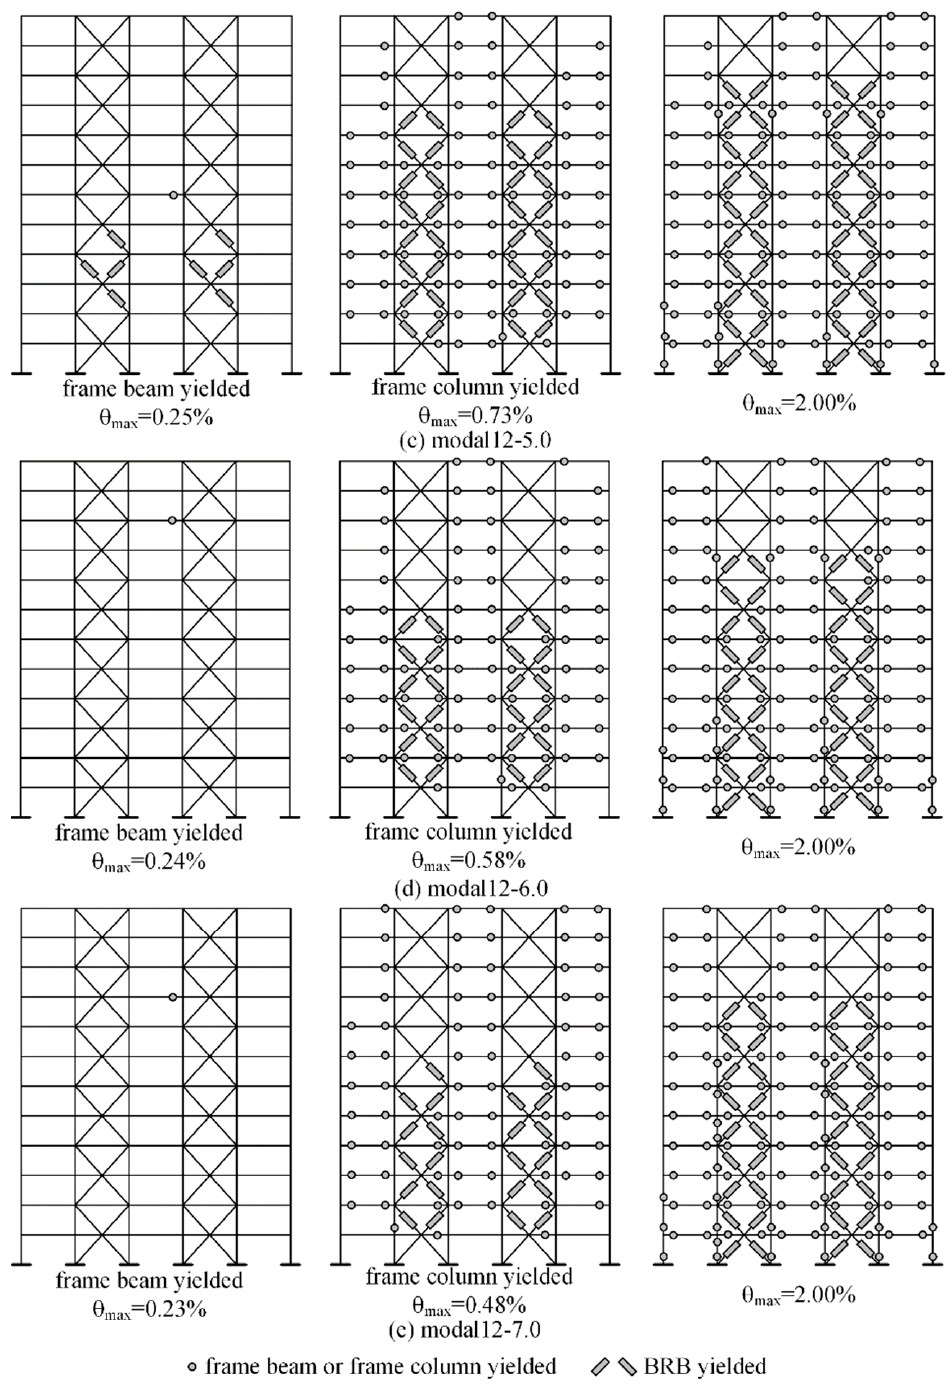
Figure 14. Beam-column yield sequence of the 12-story PCF-BRB structure.